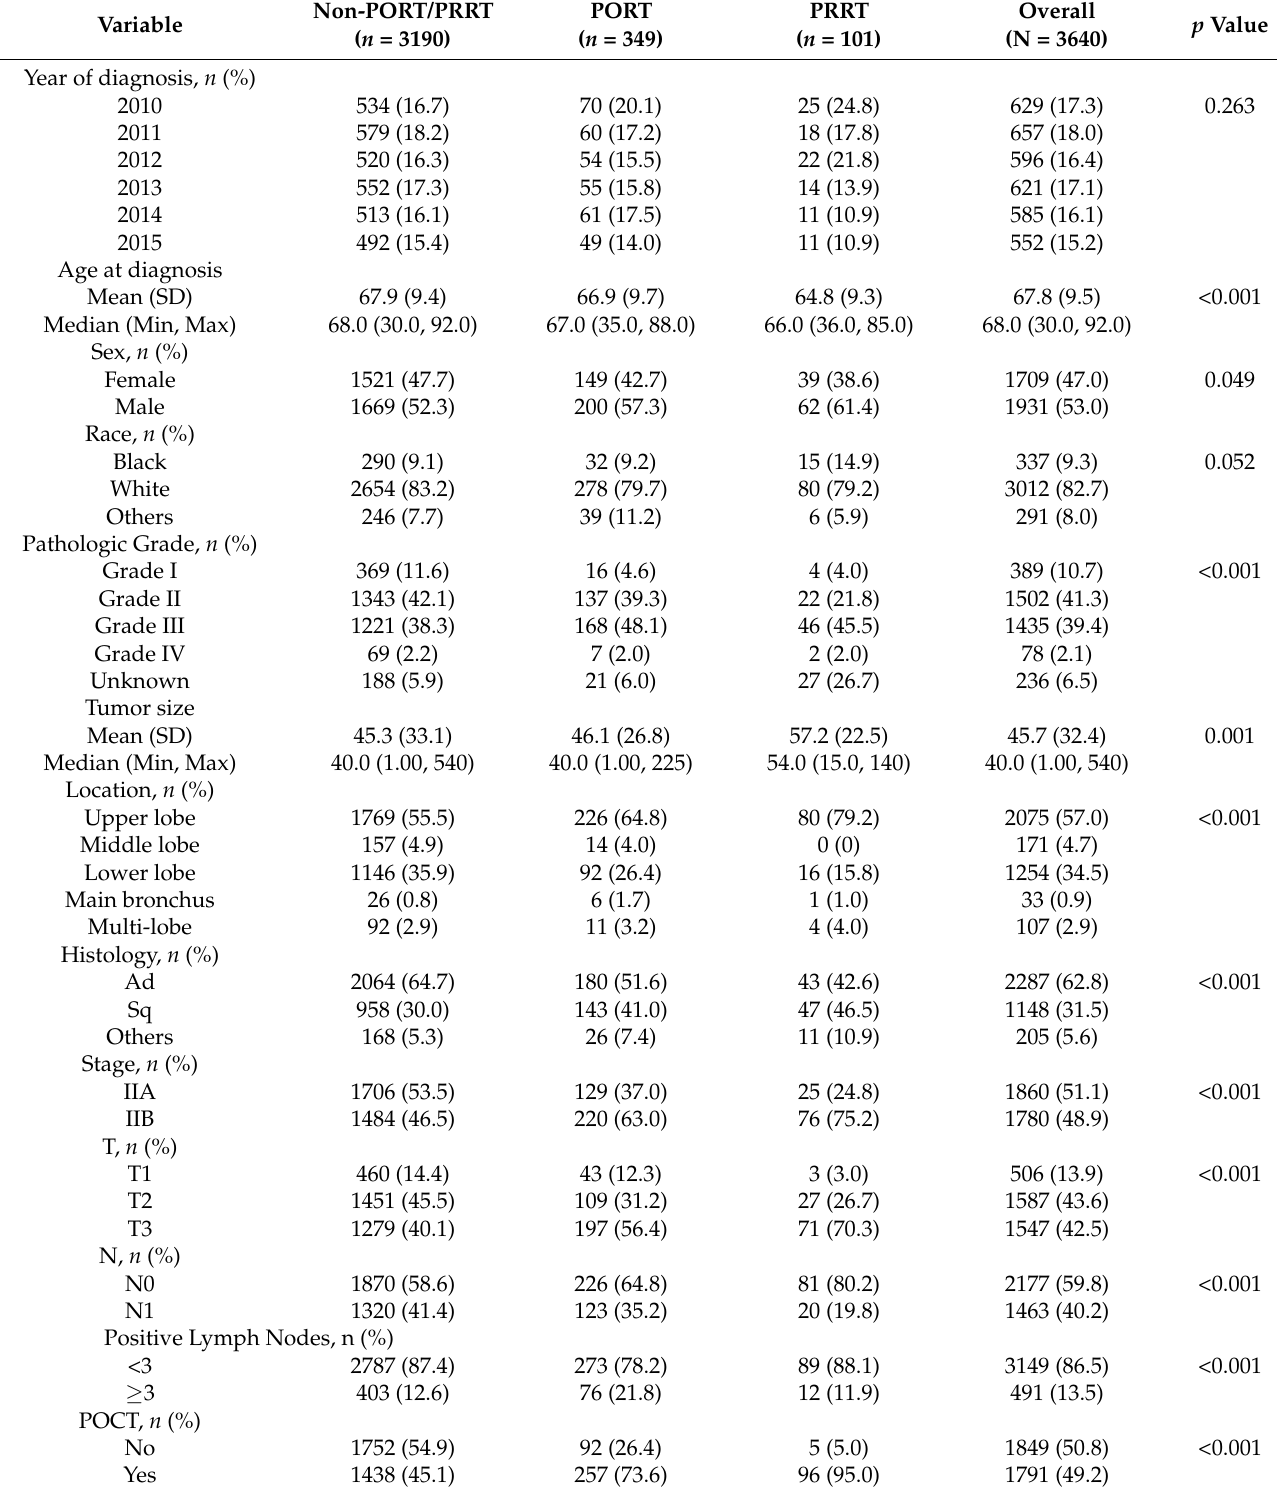
Table 1. Distribution characteristic of factors related to use of PORT or